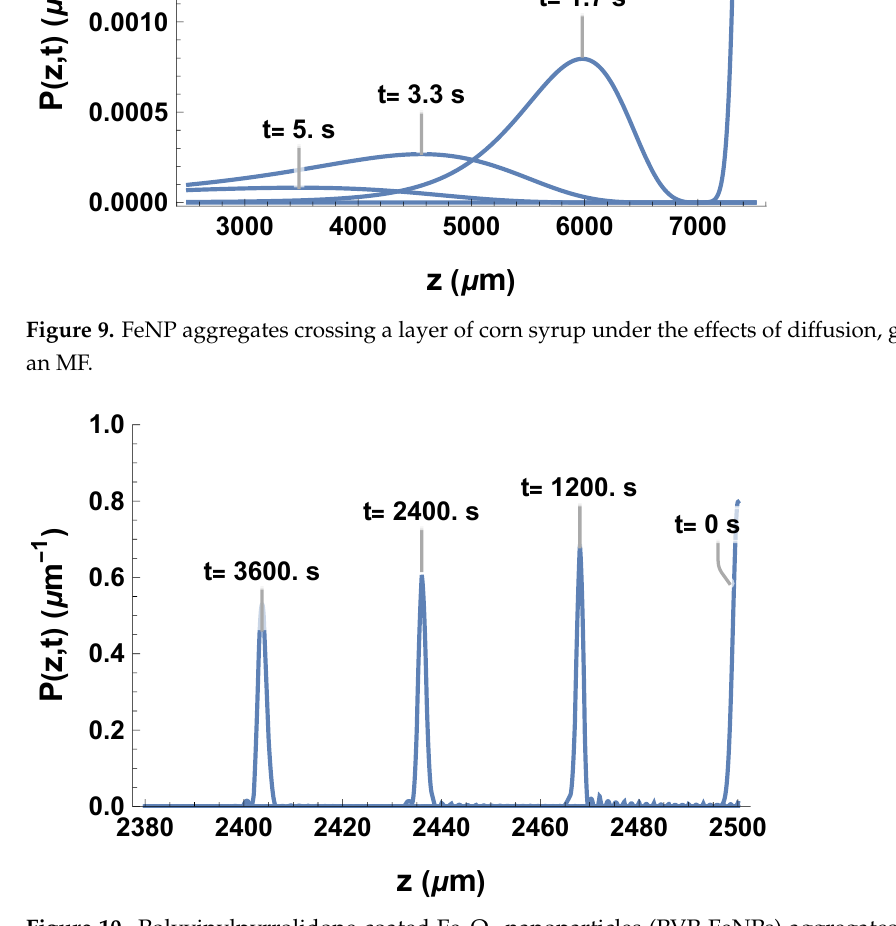
Figure 10. Polyvinylpyrrolidone coated Fe 3 O 4 nanoparticles (PVP-FeNPs) aggregates crossing a layer of mucus under the effects of diffusion, gravity, and an MF. The tiny spikes along the x -axis were the results of numerical simulations of a very sharp Dirac-delta-like initial condition at t = 0. These spikes disappeared when a Mathematica numerical cell size smaller than 1 µ m was used but that took longer to